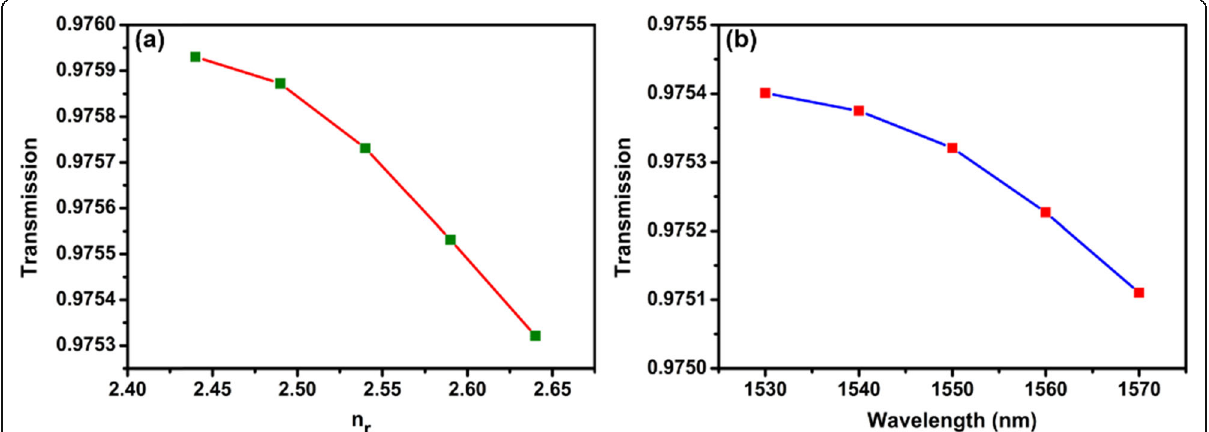
Fig. 17 Calculated transmission as a function of a n r and b wavelength